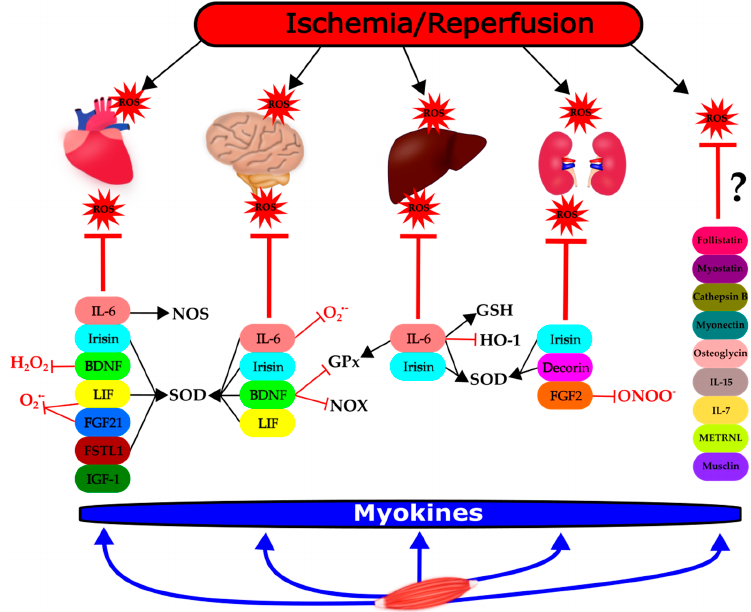
Figure 1. Modulation of ischemia / reperfusion-induced reactive oxygen species (ROS) formation and / or elimination by myokines in di ff erent organs. This figure shows the groups of myokines a ff ecting ROS or antioxidant mechanisms in the heart, brain, liver, and kidneys, respectively, in the settings of ischemia / reperfusion (thick lines). The e ff ect of the individual myokines on specific molecular targets are indicated with thin lines: T: negative e ff ect, ↑ : positive e ff ect. BDNF: brain-derived neurotrophic factor; FGF-2: fibroblast growth factor 2; FGF-21: fibroblast growth factor 21; FSTL-1: follistatin-like; GPx: glutathione peroxidase; GSH: glutathione; HO-1: heme oxygenase-1; IGF-1: insulin-like growth factor-1; IL-6: interleukin-6; IL-7: interleukin-7; IL-15: interleukin-15; LIF: leukemia inhibitory factor; METRLN: meteorin-like; NOS: nitric oxide synthase; NOX: NADPH oxidase; ONOO − :